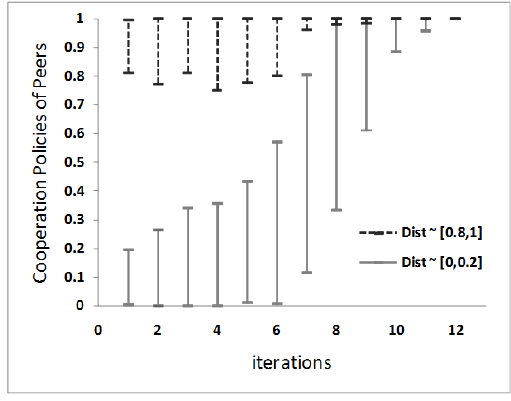
Fig. 10. The consistency of the results in adaption to a specific linear cost